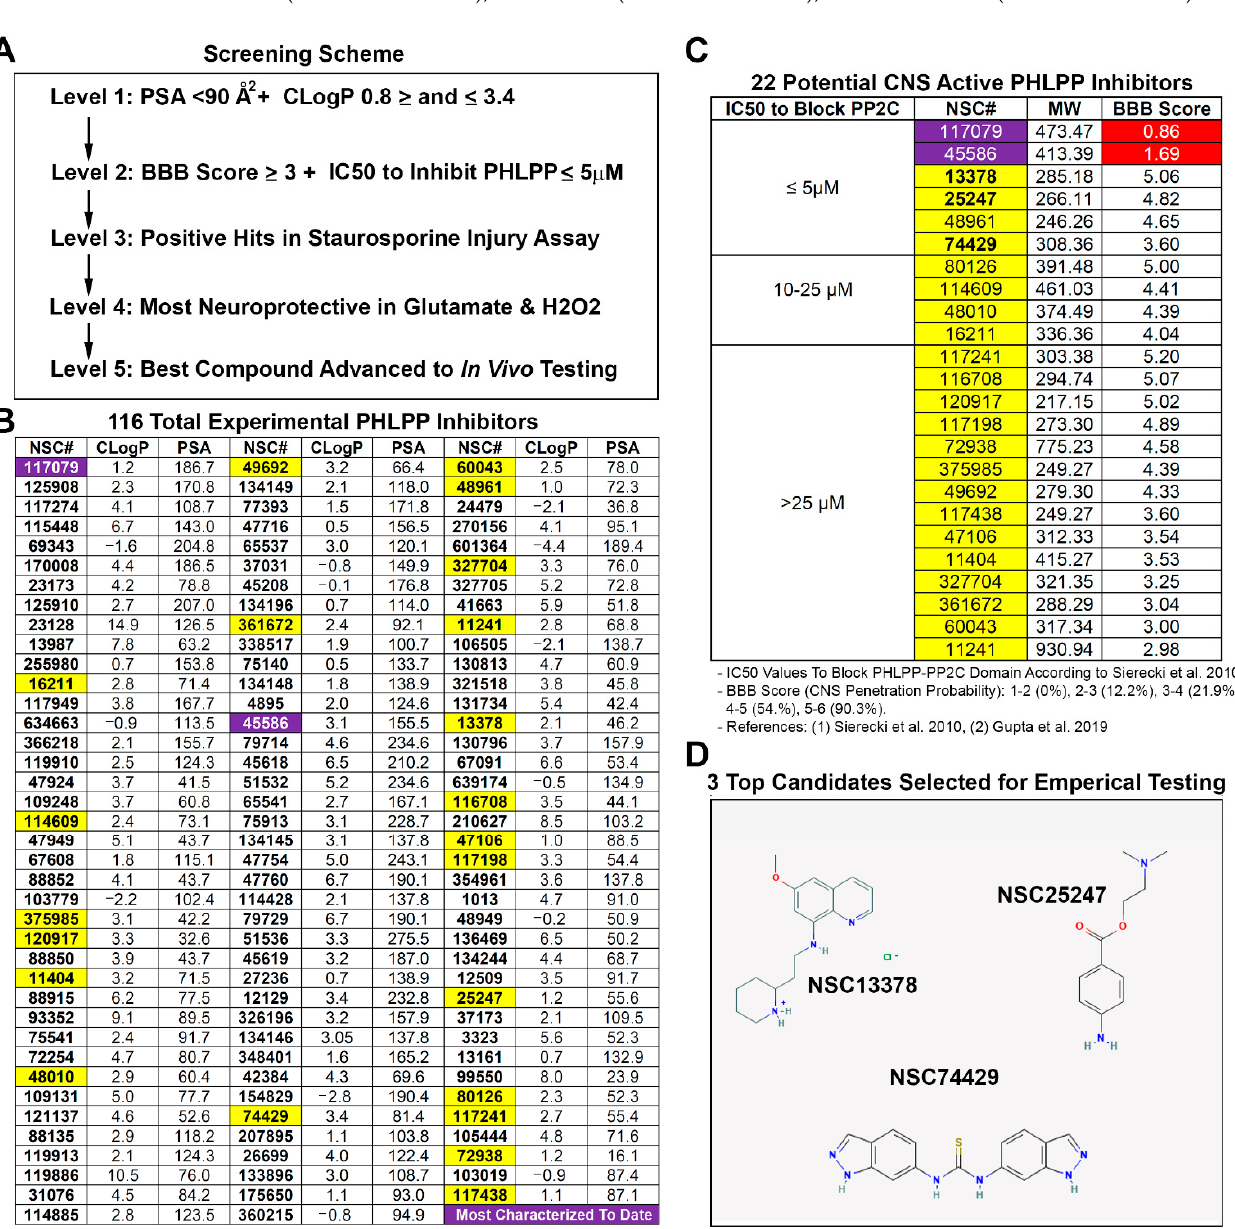
Figure 1. Physicochemical Properties of PHLPP Inhibitors and the Prediction of Their CNS Activity. ( A ) An overview of the top-down screening process employed in this study for drug selection. ( B ) The predicted polar surface aera (PSA) and calculated partition coefficient (CLogP) for each PHLPP inhibitor calculated in Chemicalize (Chemaxon). Compounds highlighted in purple denote the two PHLPP inhibitors that have received the most empirical study/characterization to date. Compounds highlighted in yellow denote unexplored PHLPP inhibitors that have chemistries supportive of BBB penetration. ( C ) The 2 most studied compounds and the 22 unexplored PHLPP inhibitors organized by known IC50s to block the PP2C domain of PHLPP2. Additionally, the BBB Score (BBB-S) was calculated for each of the compounds and arranged in each subgroup highest to lowest. The red highlighted BBB Scores indicate values < 2 and consistent with non-CNS drugs. ( D ) The chemical structures of 3 unexplored PHLPP inhibitors chosen for testing in neurons is depicted.